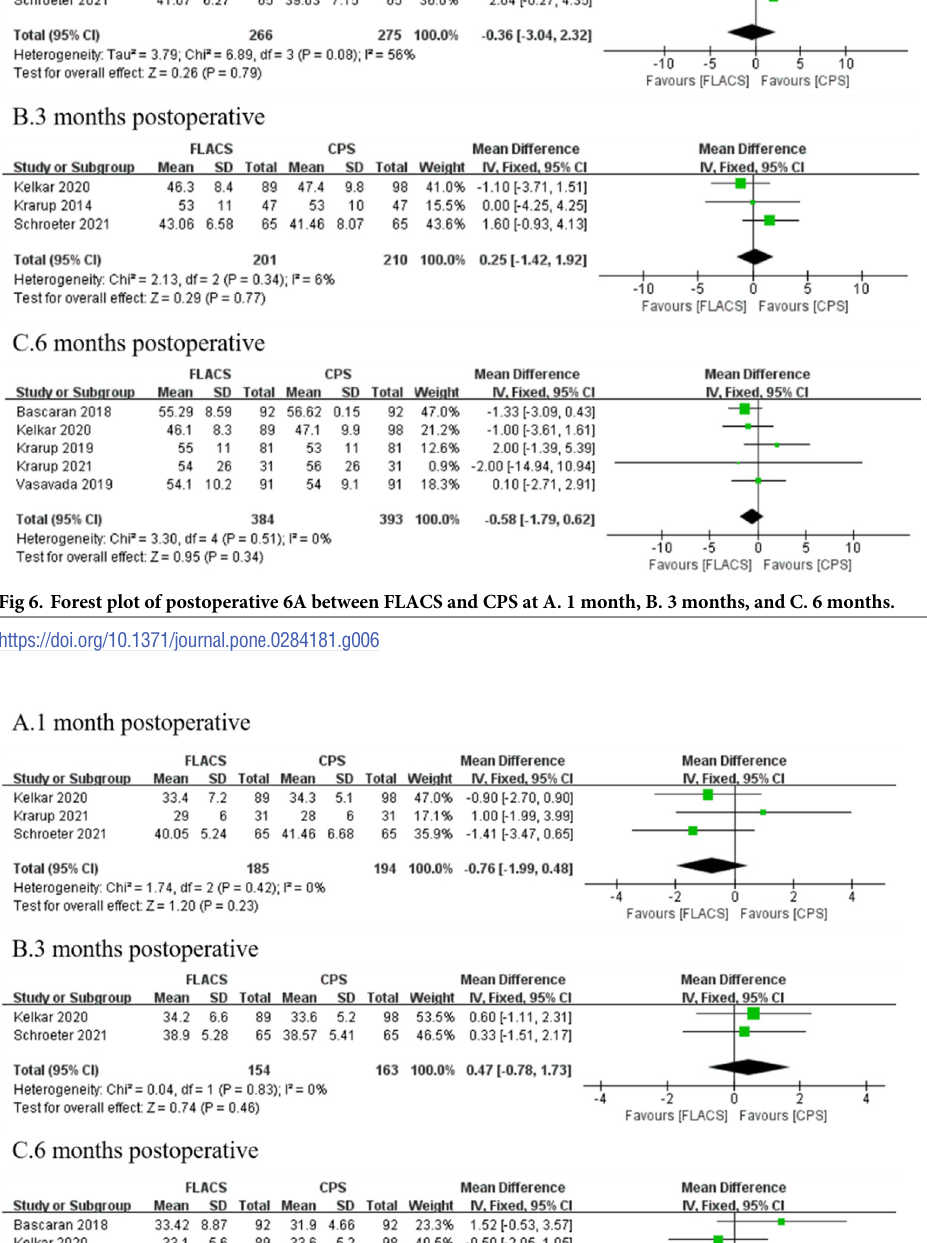
PLOS ONE | https://doi.org/10.1371/journal.pone.0284181 April 14,